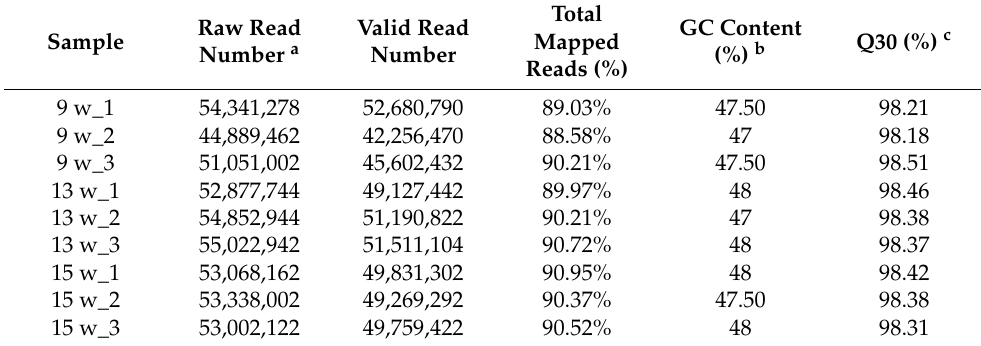
Table 1. Overview of the RNA-seq read data from the nine strawberry flower bud